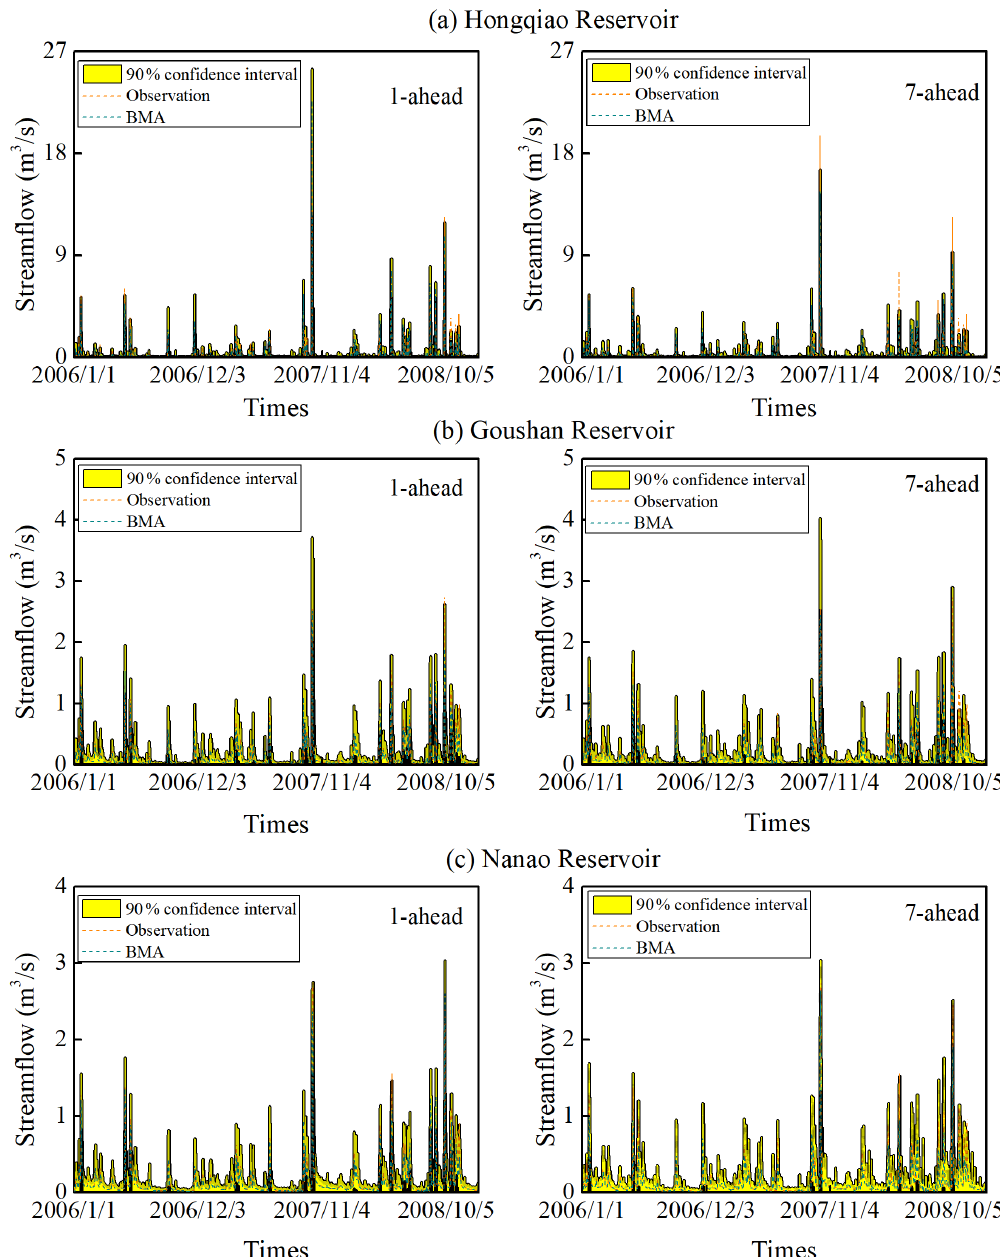
Figure 13. The 90% streamflow interval of the BMA method under